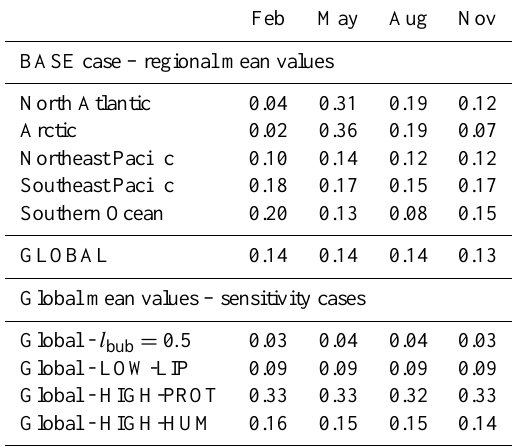
Table 3. Regional seasonal mean mass fractions for each region as defined in Fig.